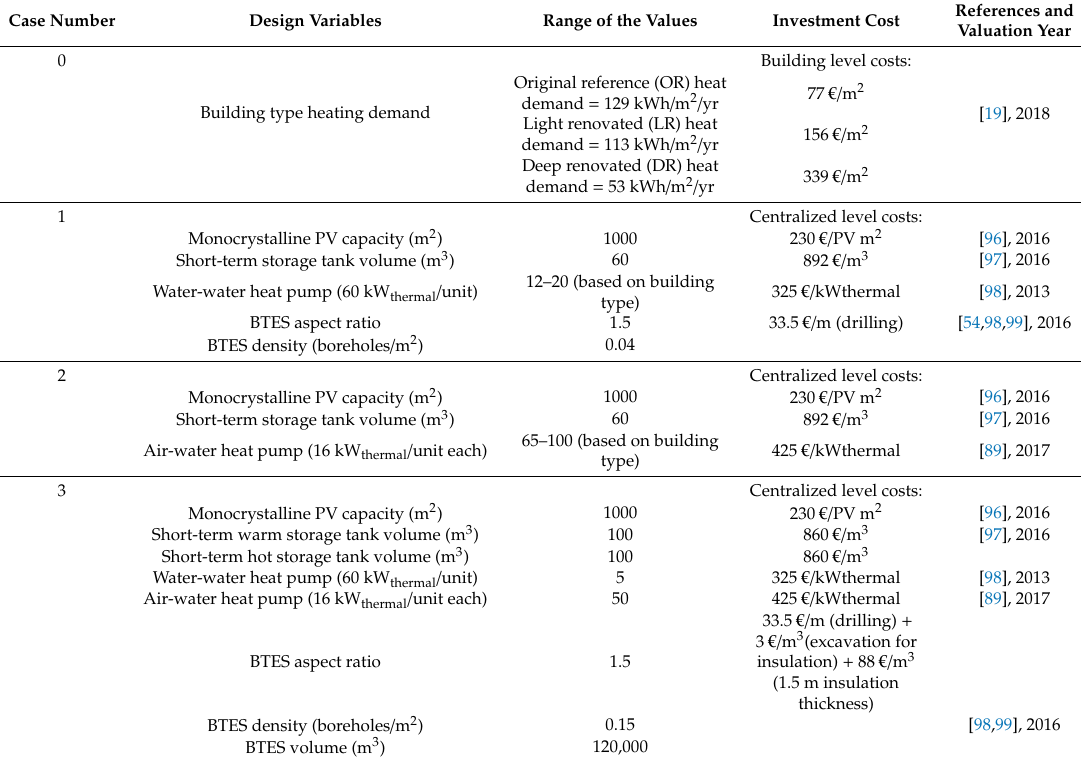
Table 3. Design variables used for the simulations and the corresponding investment costs of the